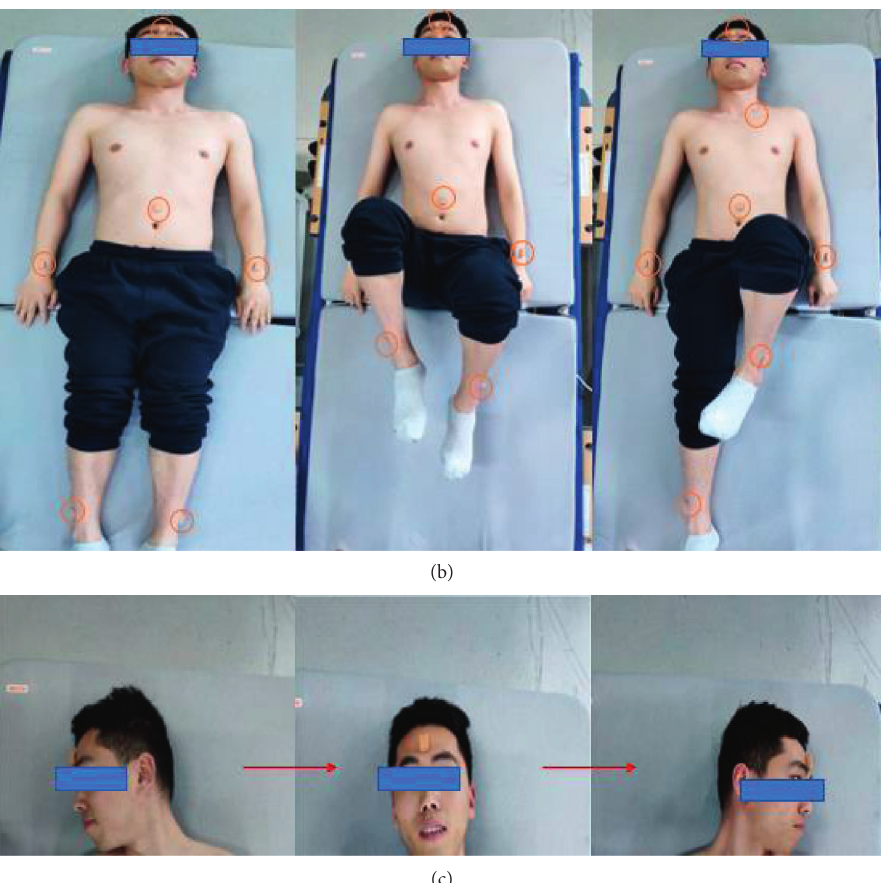
Figure 6: The demonstration test involves slight shaking of the hands, legs, and head. (a) The tester’s arm movement diagram. (b) The tester’s leg movement diagram. (c) The tester’s head-shaking picture from side to